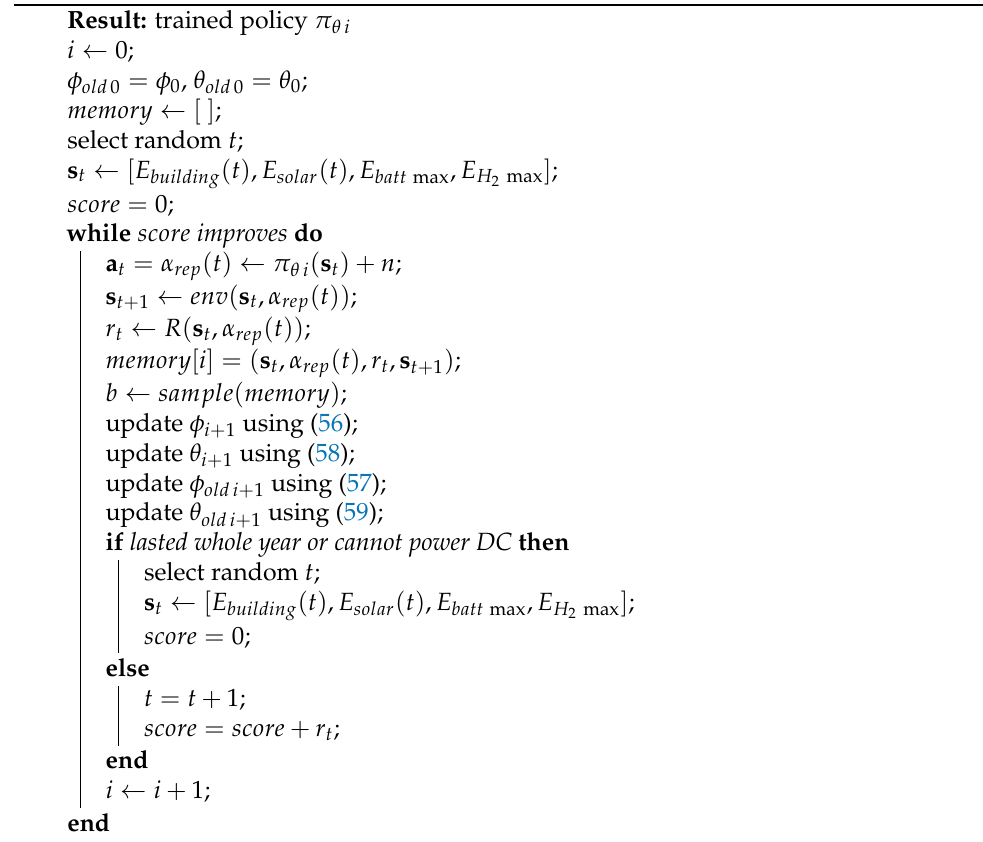
Algorithm 1: DDPG α